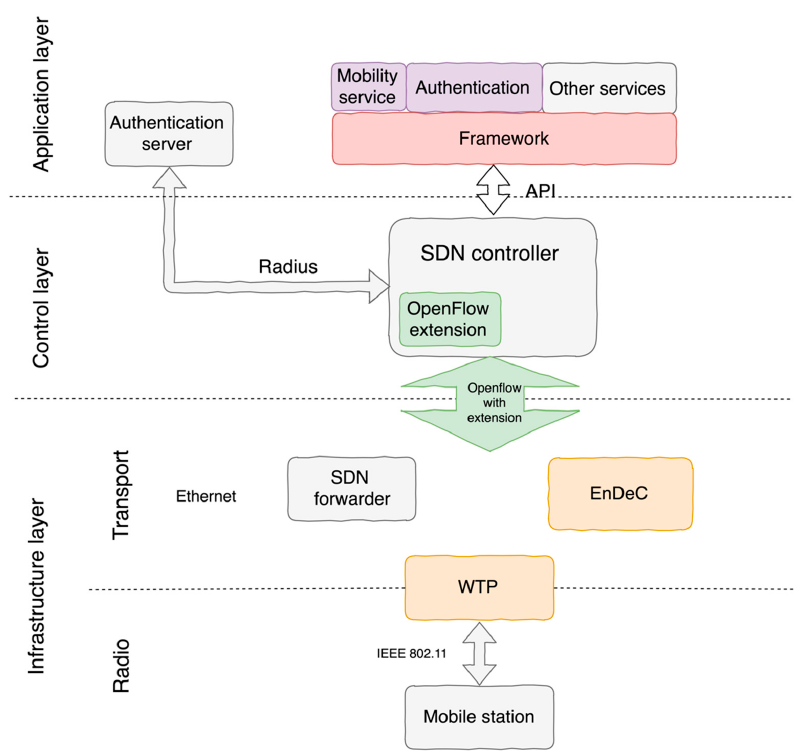
Figure 1. High-level architecture.